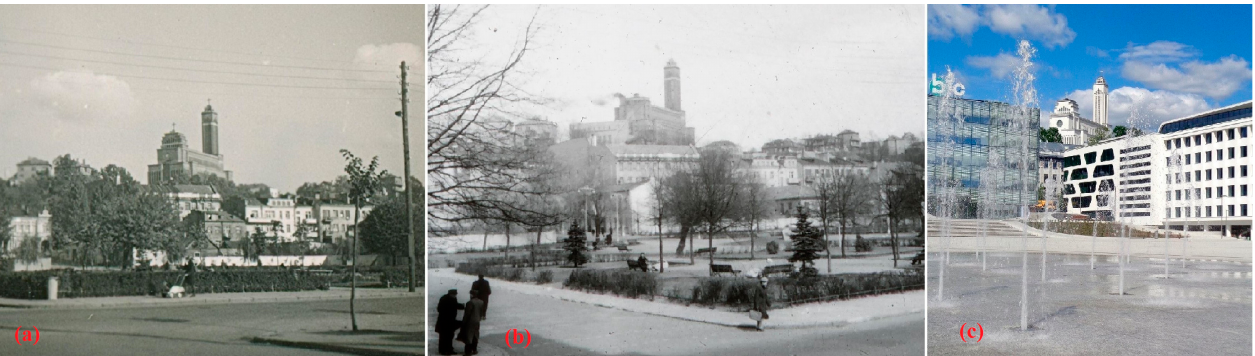
Figure 7. Christ’s Resurrection Church. View from the city’s lower terrace. ( a )1930s (source: Kaunas City Museum); ( b ) 1960s (photographer Stanislovas Lukošius, source: Kaunas City Museum); ( c ) 2020 (photo courtesy of Arvydas Pakštalis).